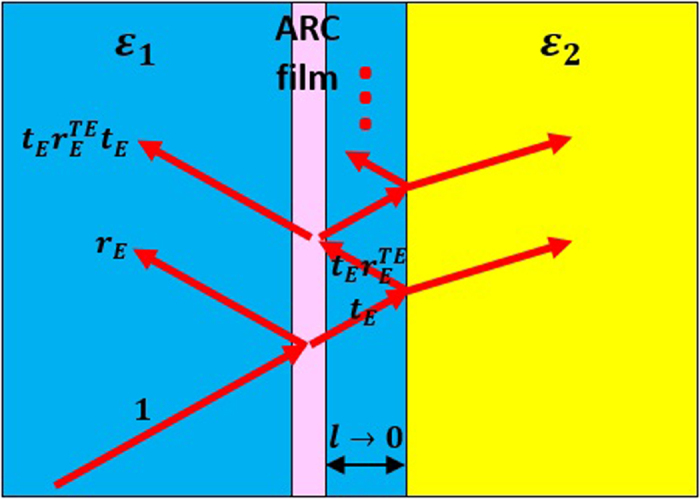
Illustration of the derivation of the antireflection condition for the case of constant tangential electric fields.